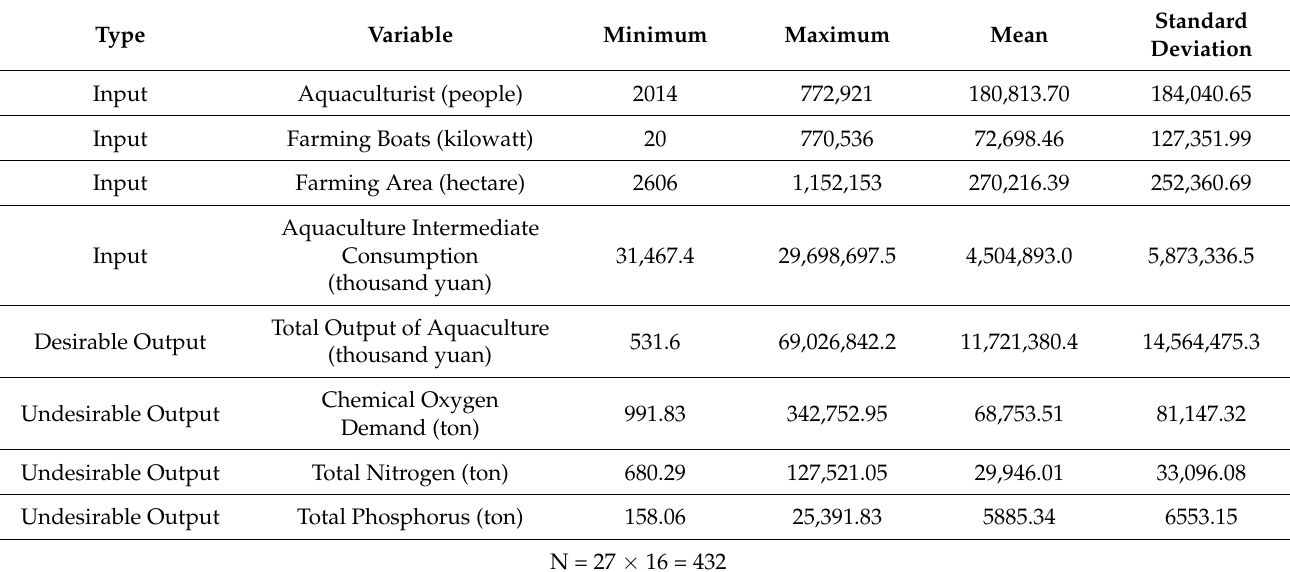
Table 1. Descriptive